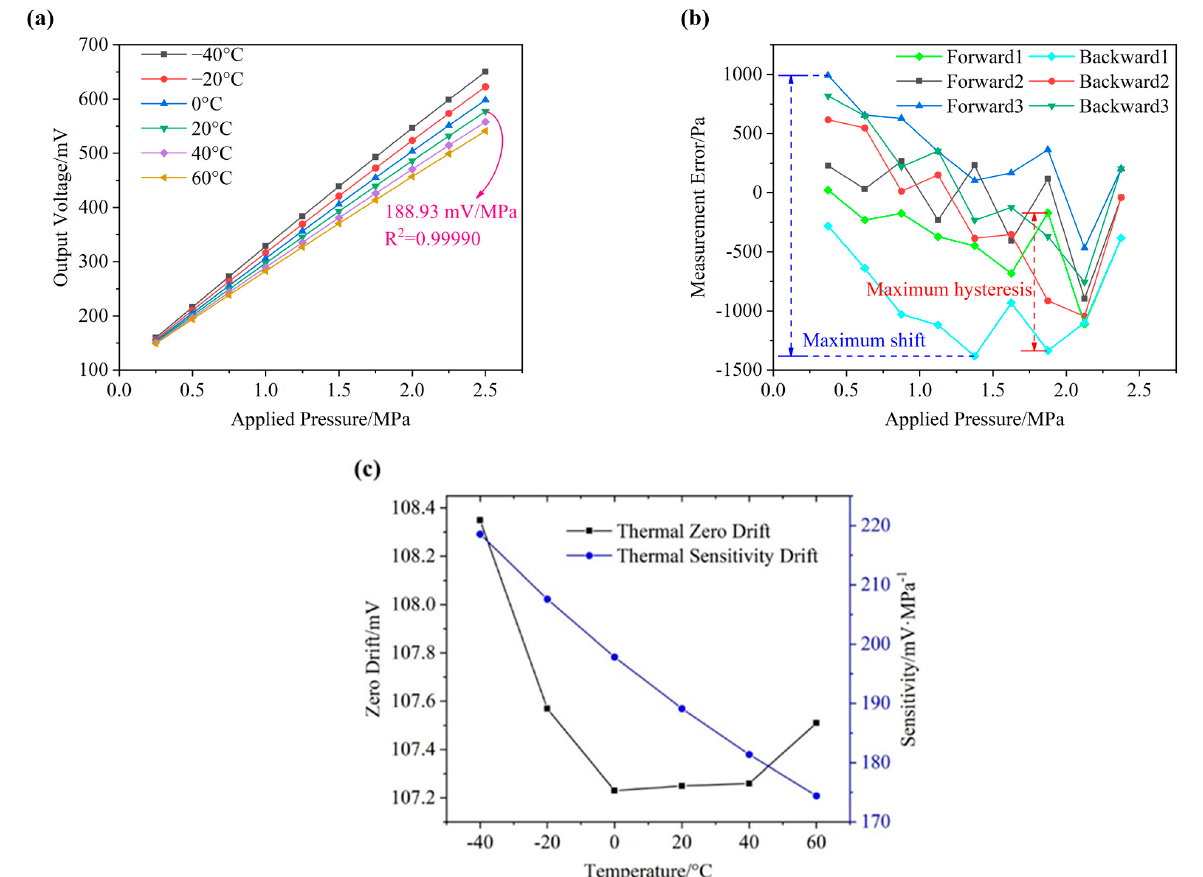
Figure 8. Characterization of the developed piezoresistive pressure sensor with optimized positions of piezoresistors: ( a ) the output voltage under the functions of pressure and temperature variations; ( b ) the measurement errors as a function of cycled pressure at a temperature of 20 ◦ C; ( c ) the zero drift and sensitivity drift as a function of temperature from − 40 to 60 ◦ C. Table 1. Output of the sensor under the cycle